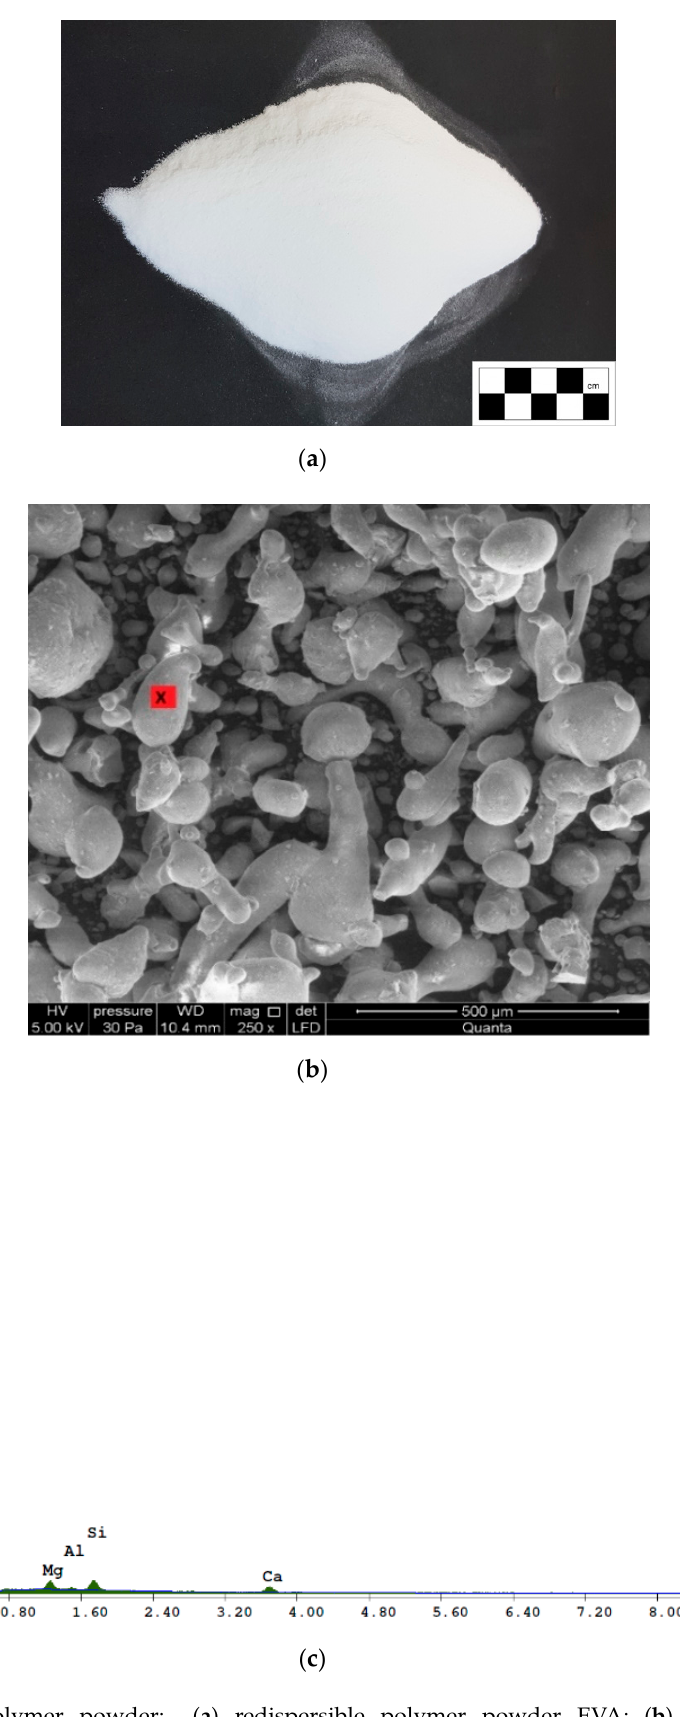
Figure 1. Polymer powder: ( a ) redispersible polymer powder EVA; ( b ) microstructure; and ( c ) chemical composition. The red marker indicates the point at which chemical analysis was conducted.